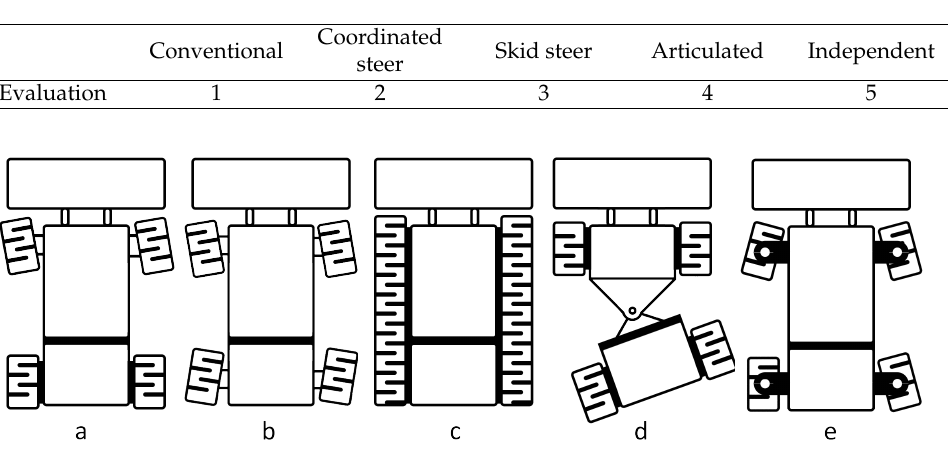
Figure 3. Key metrics—steering: ( a ) conventional; ( b ) coordinated steer; ( c ) skid steer; ( d ) articulated; ( e )